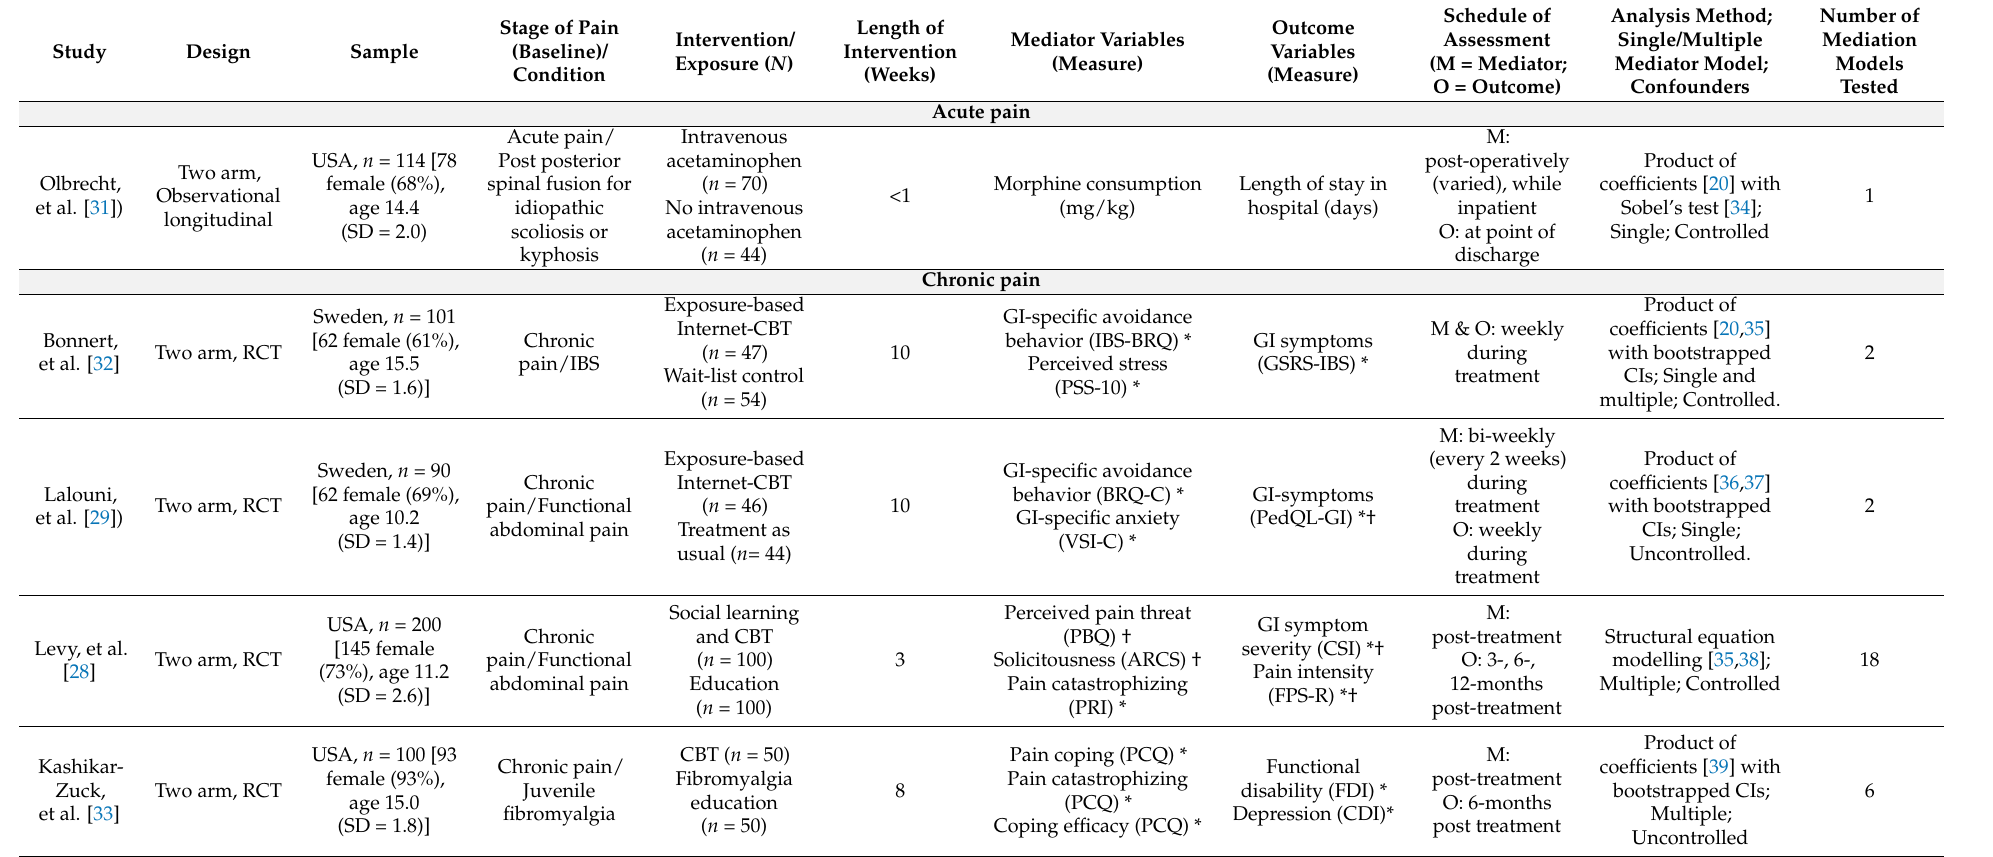
Table 1. Summary of characteristics of included